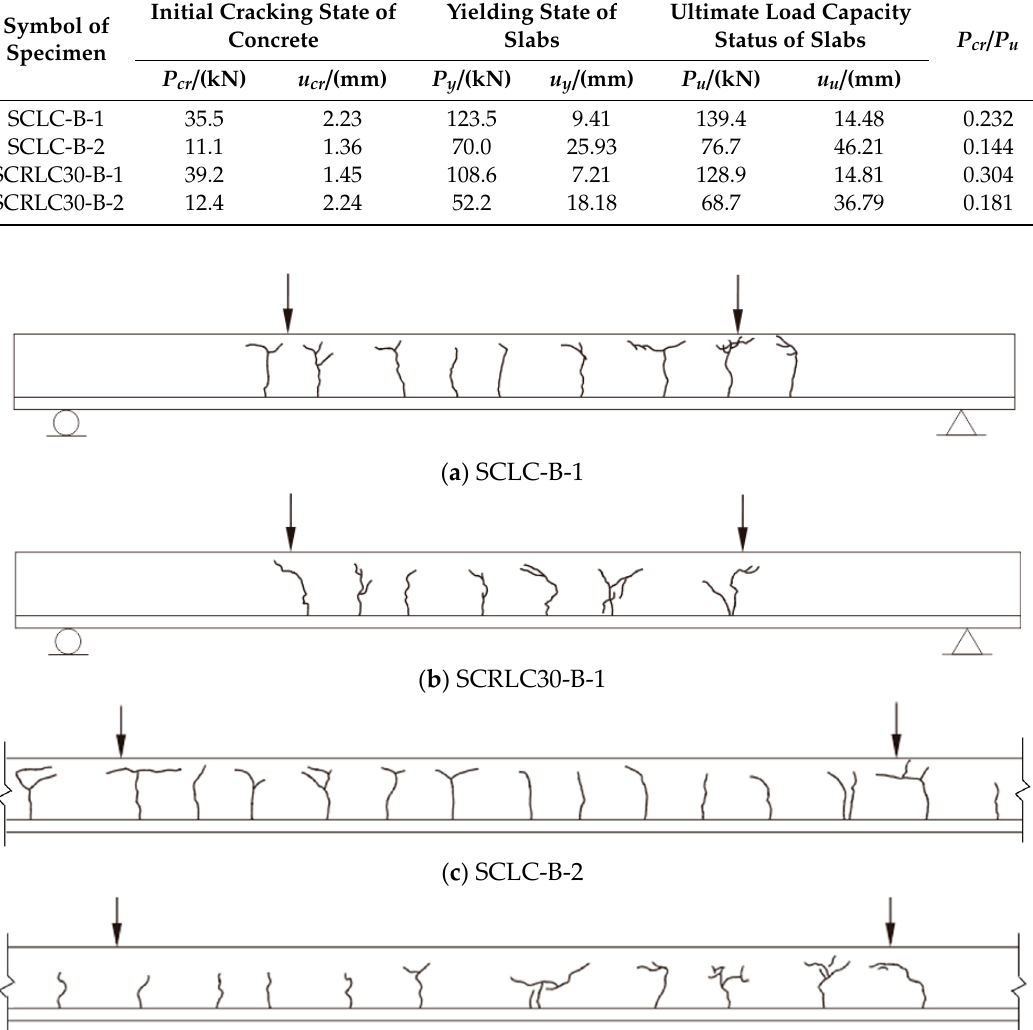
Figure 10. Typical failure modes of composite slab specimens (for SCLC-B-1). Specimens SCLC-B-1 and SCLC-B-2 exhibited an almost alike failure pattern. Meanwhile, specimens SCRLC30-B-1 and SCRLC30-B-2 had the similar failure mode. For all four composite slabs,